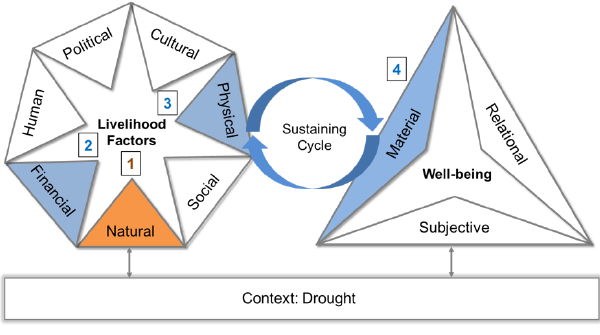
Fig. 5 . The integrated sustainable livelihoods approach and well-being framework for northeastern Colorado livestock producers illustrating a contraction strategy, with orange depicting losses and blue indicating elements that gained or maintained. (1) First, severe drought negatively impacted the natural factor. (2) To maintain the high-value natural factor, the producer leveraged his financial factor in the form of commercial cattle to reduce grazing. (3) As the drought progressed and the commercial animals’ reduction was insufficient, the producer utilized the physical infrastructure to maintain calves in the feedlot. (4) These combined strategies preserved the high-value resources of grazing land and registered cattle, enabling the producer to rebound from the drought